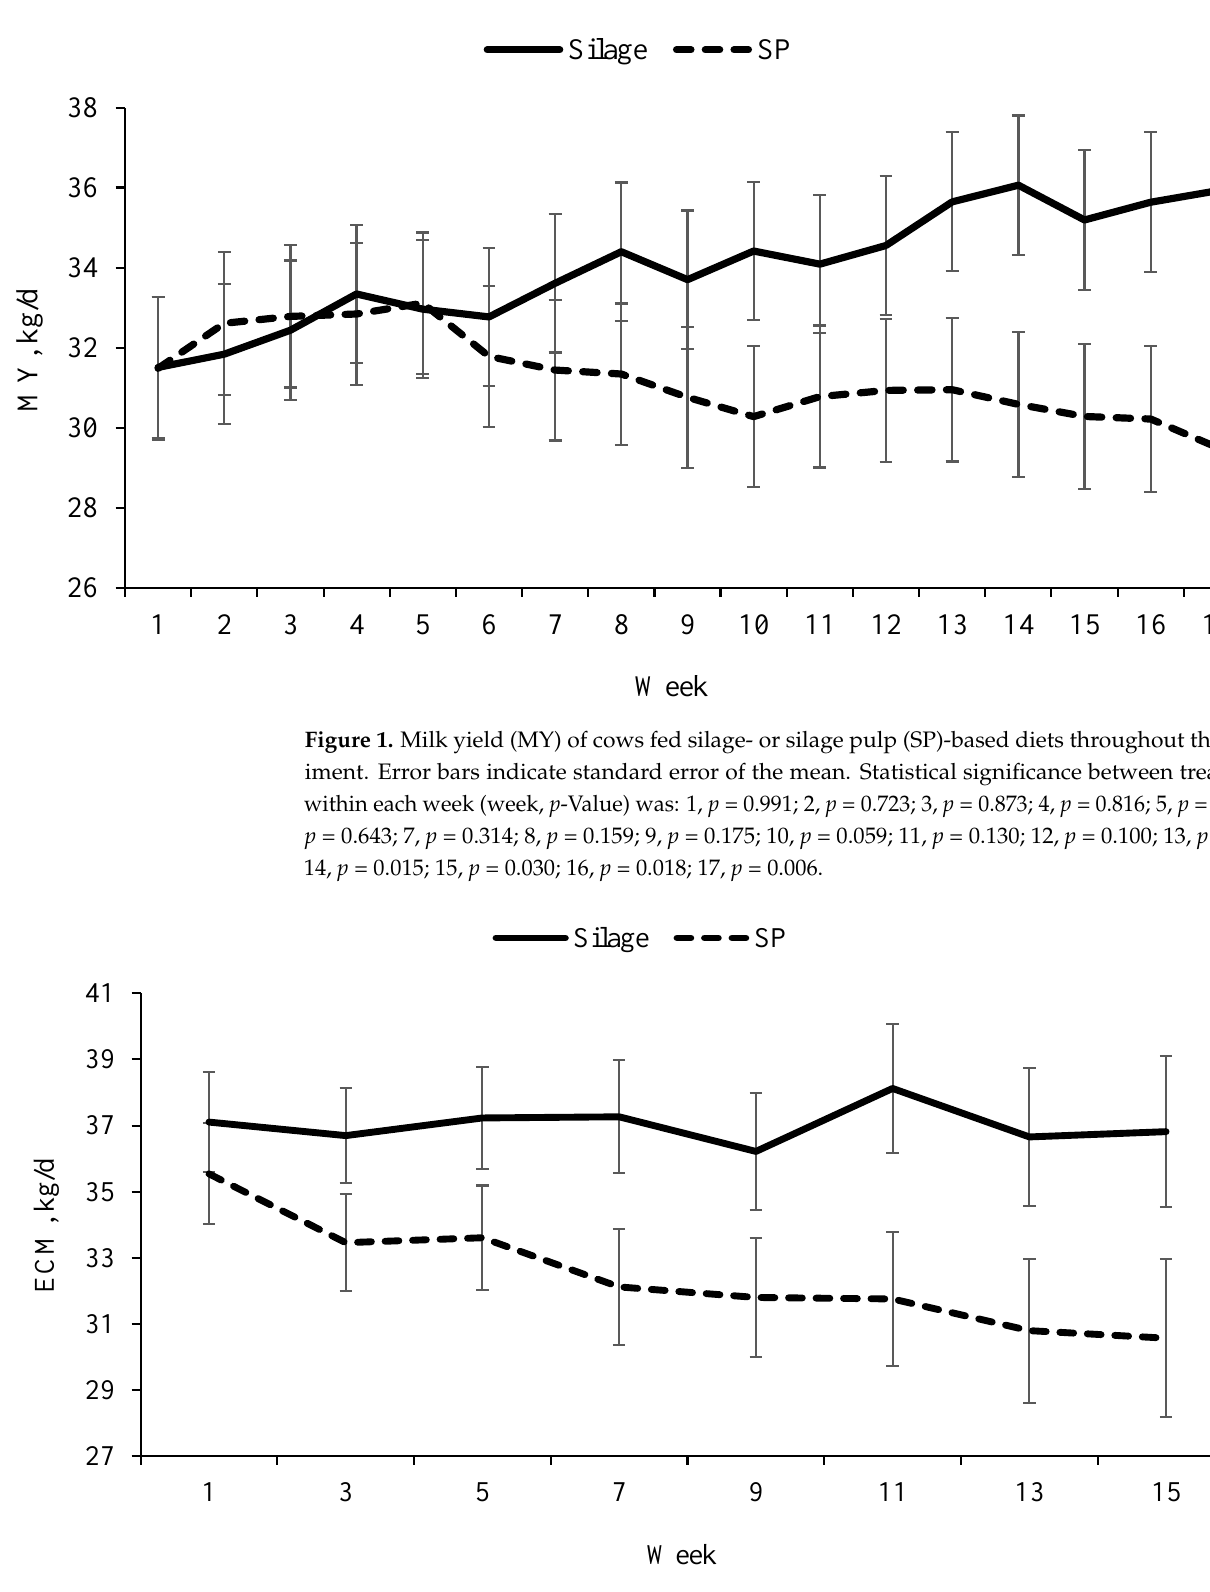
Figure 2. Energy corrected milk (ECM) yield of cows fed silage- or silage pulp (SP)-based diets throughout the experiment. Error bars indicate standard error of the mean. Statistical significance between treatments within each week (week, p -Value) was: 1, p = 0.270; 3, p = 0.015; 5, p = 0.019; 7, p = 0.007; 9, p = 0.026; 11, p = 0.008; 13, p = 0.025; 15, p = 0.034.